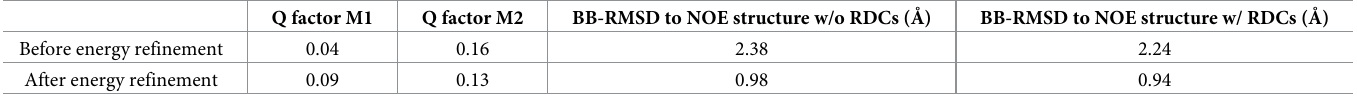
Table 2. Results from structure calculation of PF2048.1 using 228 RDCs and secondary structure restraints are shown.